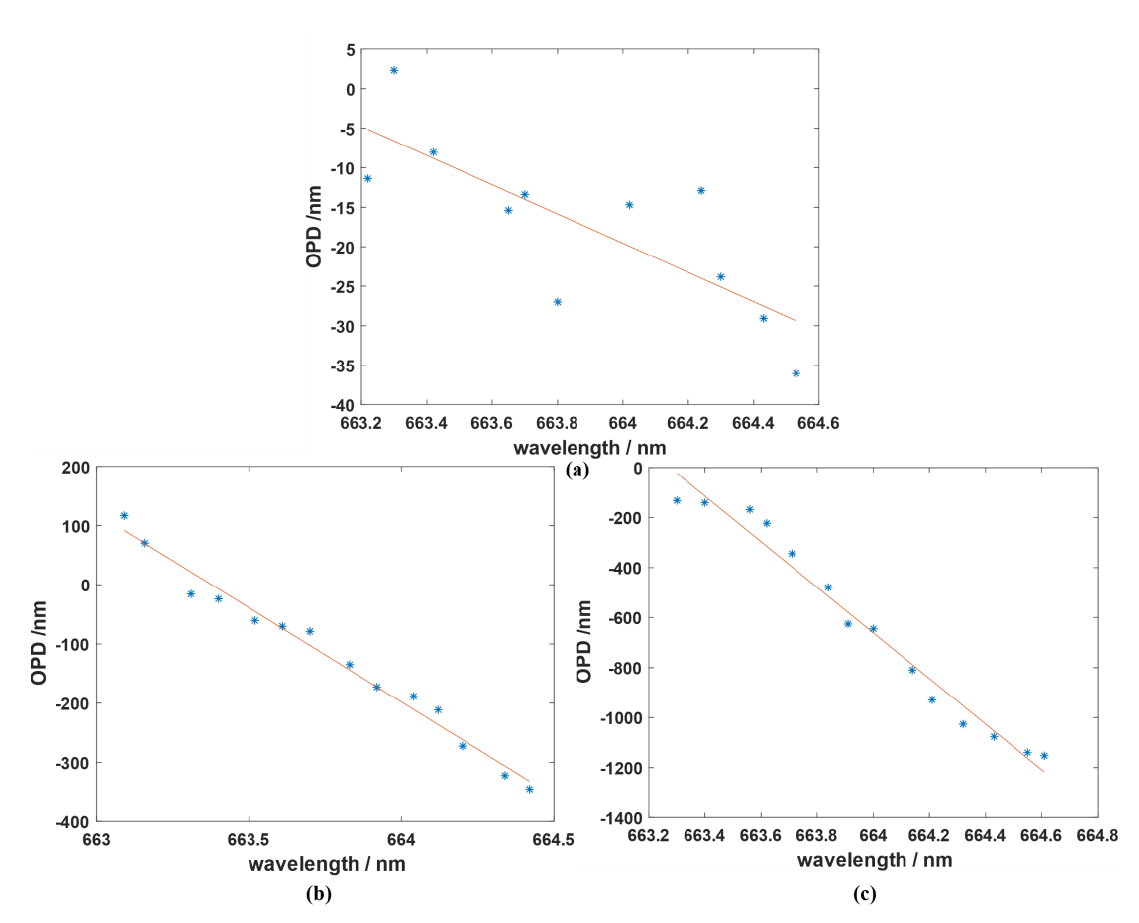
Figure 8. Piston error experiment result. ( a ) Original case; ( b ) − 100 µ m piston input; ( c ) − 300 µ m input.